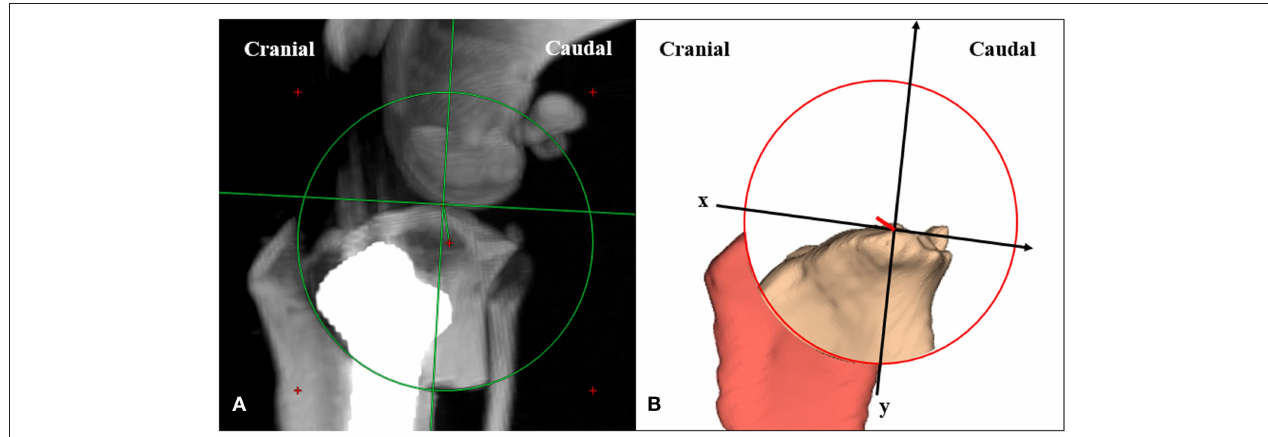
FIGURE 6 | Measuring the distance and the direction of eccentricity. (A) The distance between the intended center of the osteotomy at the tibial long axis and the center of the actual osteotomy is defined as the distance of eccentricity. (B) The tibial long axis is defined as y-axis. The x-axis is defined perpendicular to the tibial long axis.